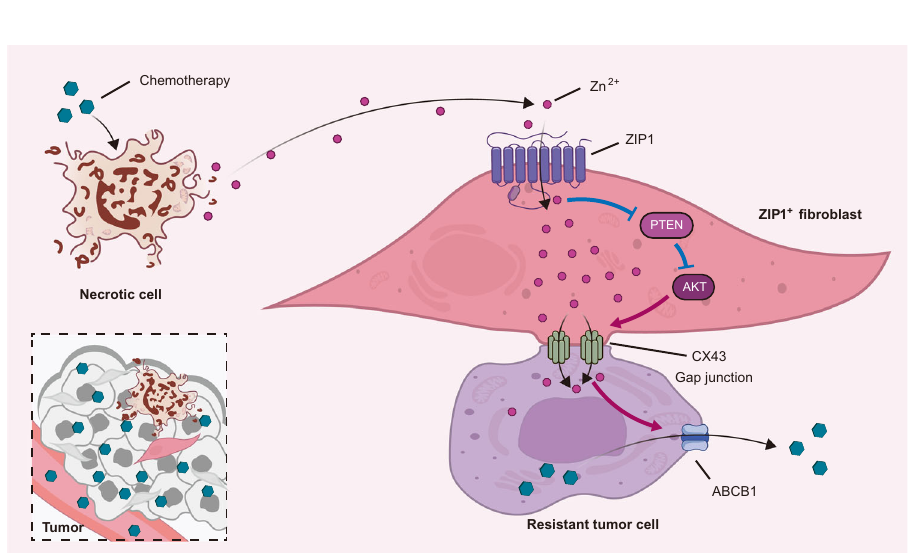
Fig. 9 | ZIP1 + fi broblasts interconnect lung cancer cells via upregulating CX43 and promote chemoresistance by Zn 2+ transfer. Chemotherapy treatment induces Zn 2+ released from dying cancer cells and the enrichment of ZIP1 + fi bro- blasts. ZIP1 + fi broblasts interconnect cancer cells with gap junctions by upregulat- ing CX43. Upon treatment, the ability of Zn 2+ uptake by cancer cells is suppressed.